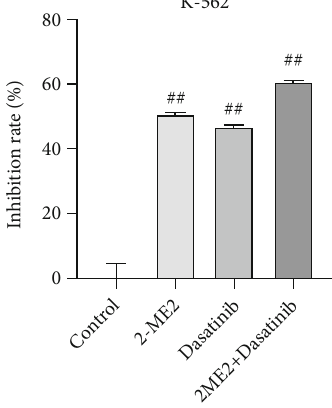
Figure 5: The inhibitory rate detection of K-562 cells 24h after single drug administrations and combined administration. Compared with control group, ## P < 0 : 01